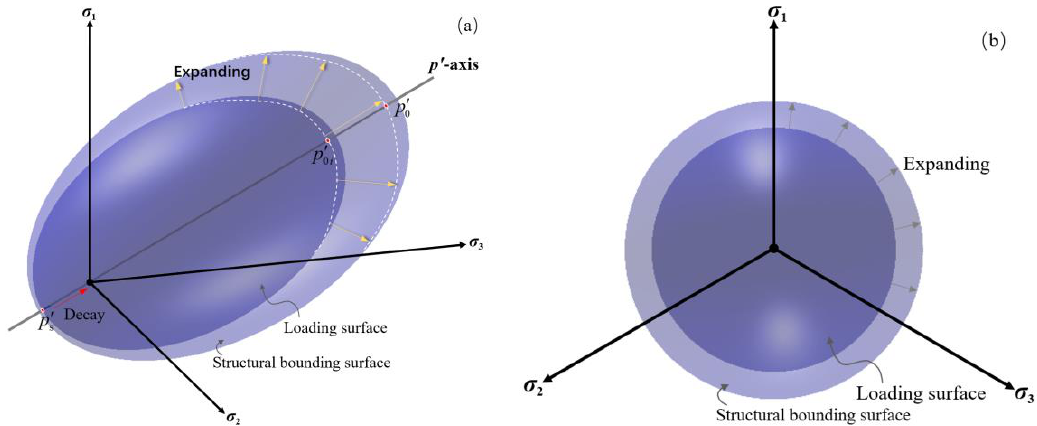
Figure 3. Loading surface and mapping rule in ( a ) principal stress space and ( b ) deviatoric plane.